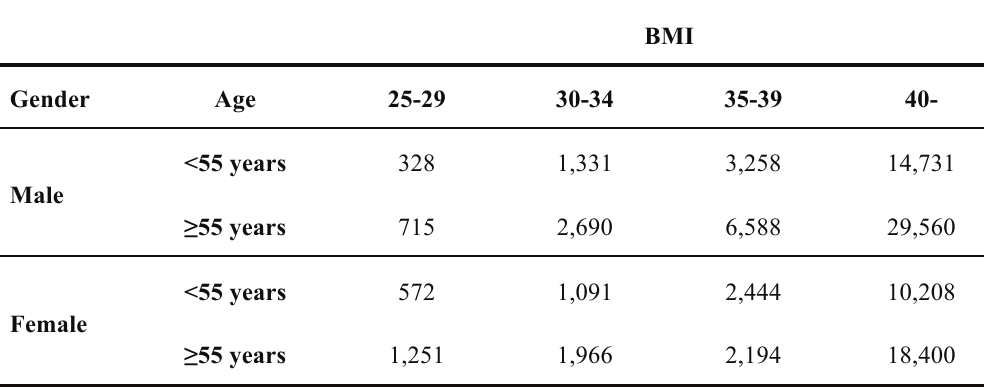
Table 1: Excess treatment cost per capita related to overweight and obesity*, Sweden (Year 2012 SEK)